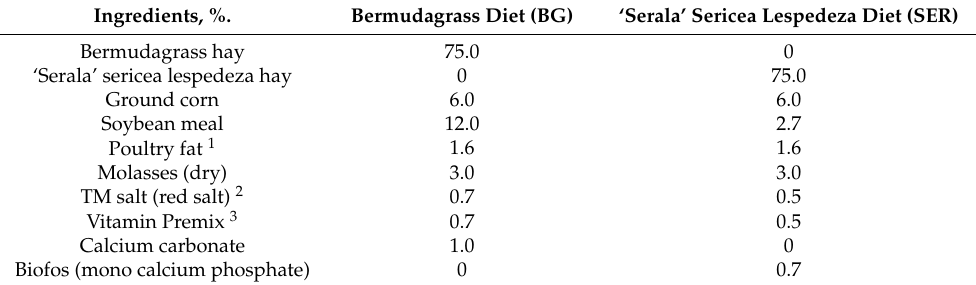
Table 1. Ingredients of the diets (hay + concentrate). Ingredients, %. Bermudagrass Diet (BG) ‘Serala’ Sericea Lespedeza Diet (SER) Bermudagrass hay